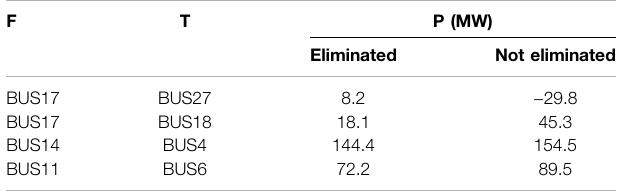
TABLE 8 | The power fl ow distribution of section B with or without eliminating individuals of power fl ow reverse. F T P (MW)